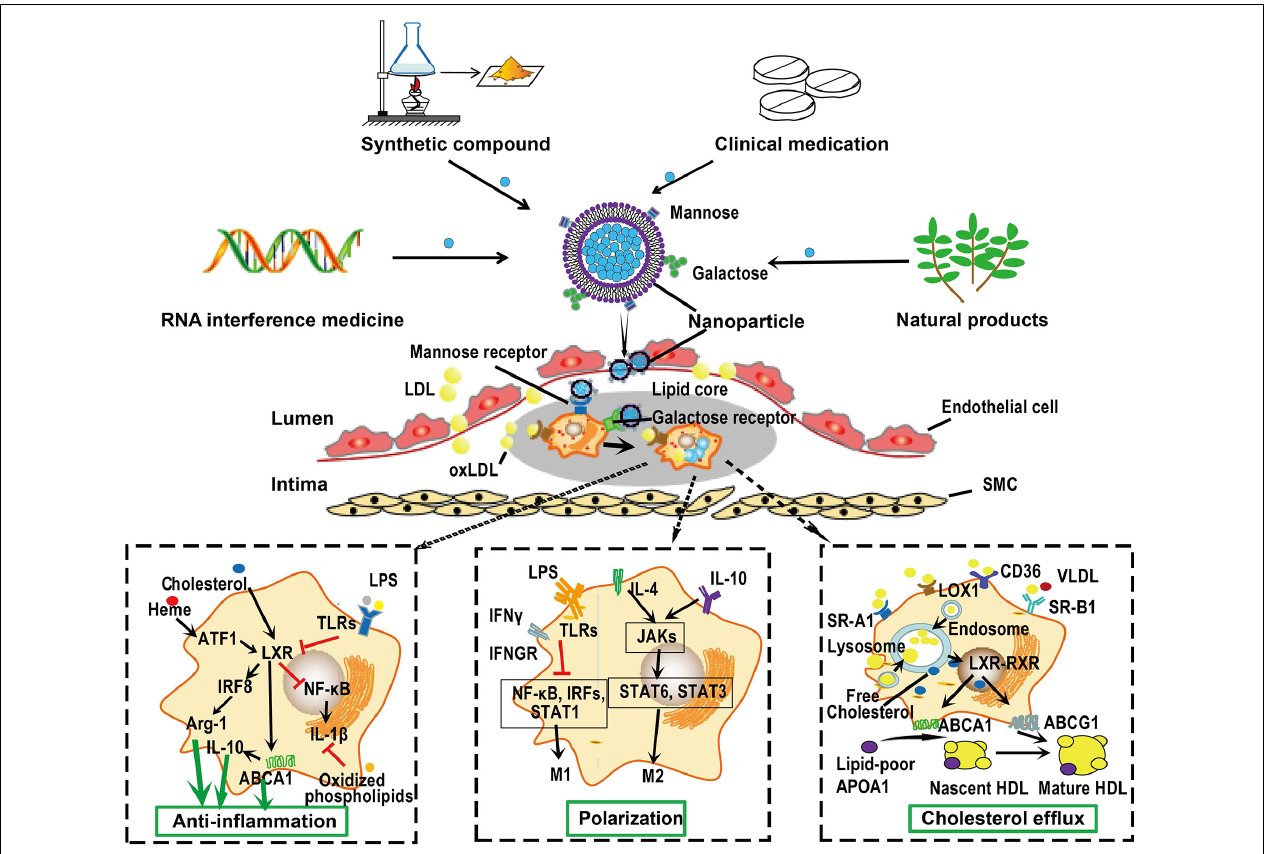
FIGURE 4 | Macrophage-targeted drug delivery. Macrophages can endocytose particles from nanometers to micrometers in size. Furthermore, distinct macrophage phenotypes express distinct cell surface receptors that can bind special ligands. This raise the possibility of delivering drugs targeting atherosclerotic plaque macrophages. Drugs or siRNA can be carried by nanoparticles, whose surface are specifically modified by ligands, such as mannose and galactose, that can be recognized by receptors on the surface of macrophages. These nanoparticles can be captured by macrophages on the surface or within the atherosclerotic plaques. Once in position, these nanoparticles can be disassembled and drugs are released to exert their functions such as anti-inflammation, promoting macrophage polarization and cholesterol efflux. Given the monotherapy of lipid-lowering drugs could not completely retard the progression of atherosclerosis, these nanoparticles may be designed to carry several compounds with different functions, thereby promoting the efficiency of treatment. ABC, ATP-binding cassette; ATF, activating transcription factor; IRF, interferon regulatory factor; JAK, Janus kinase; LDL, low-density lipoprotein; NF- κ B, nuclear factor-kappa B; RXR, retinoid X receptor;